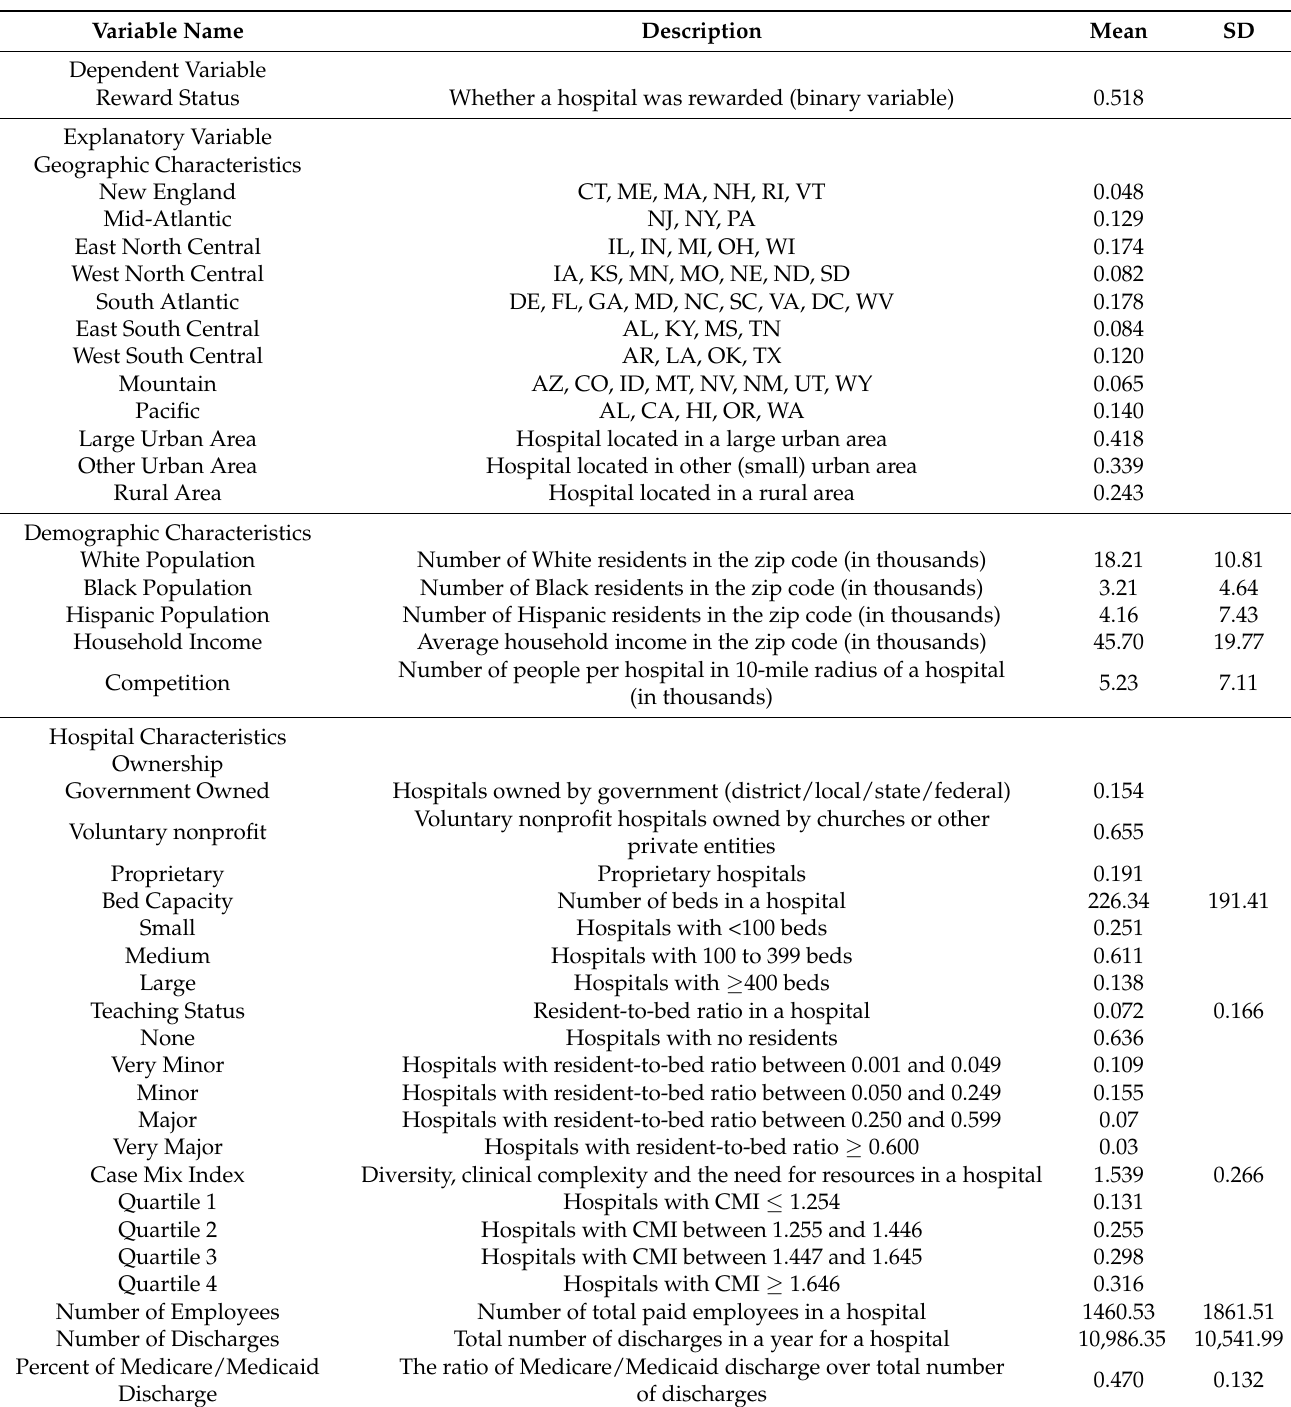
Table 5. Summary of dependent and explanatory